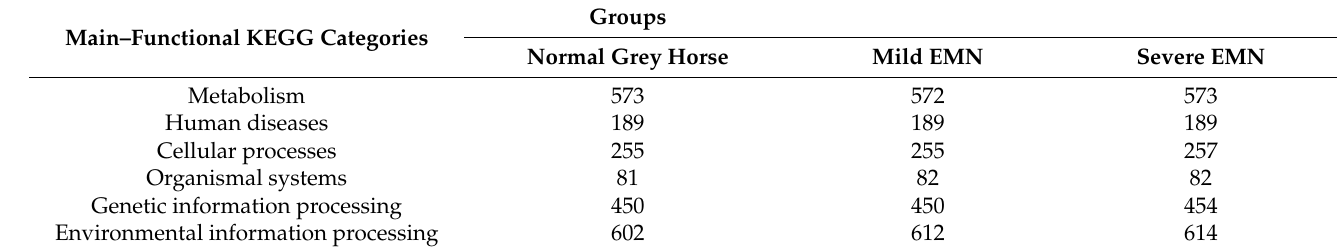
Table 3. Main functional KEGG categories 3 groups of the experimental grey horses EMN of the faeces